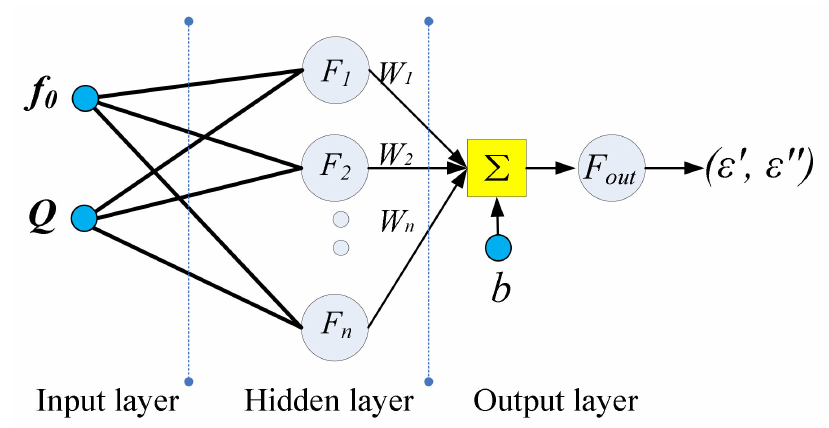
Figure 6. Structure of the